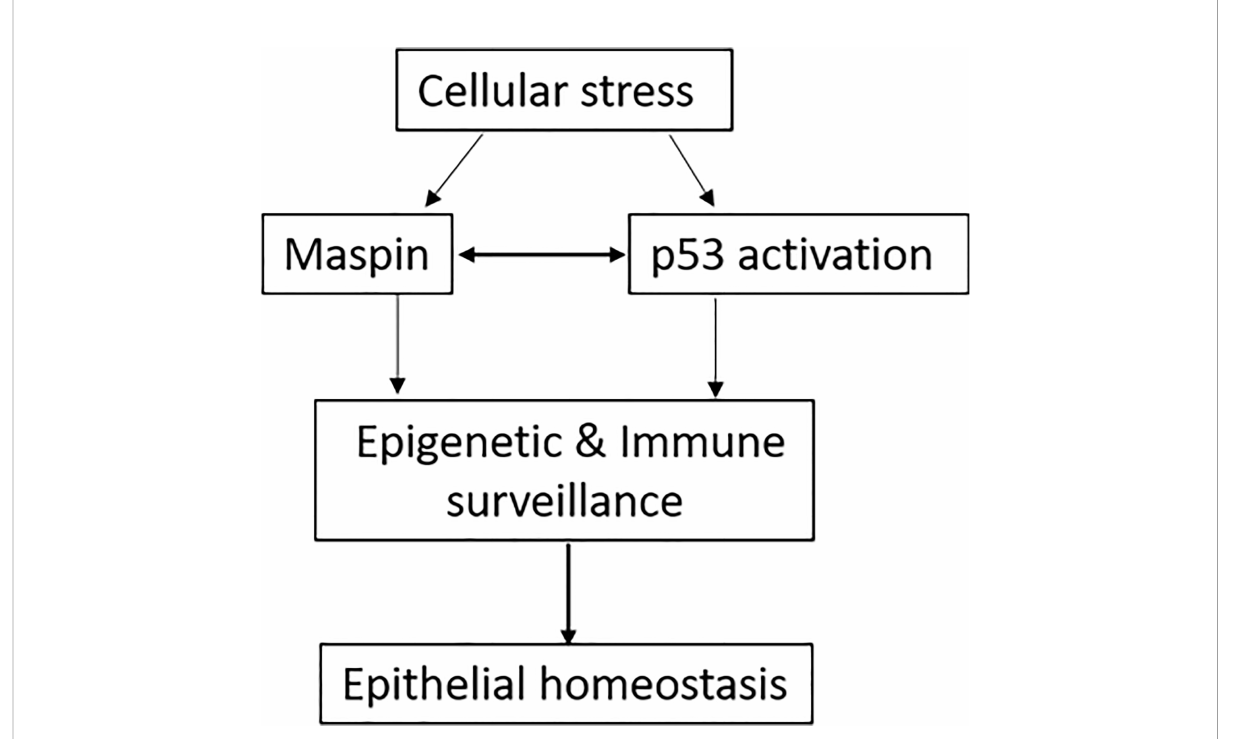
FIGURE 3 The schematic of Maspin and p53 working hypothesis. Cellular stress promoted the integration of Maspin and p53, in turn arousing host epigenetic and immune surveillance to protect the epithelial digressional process until discharging the cellular stress, consequentially retuning the epithelial